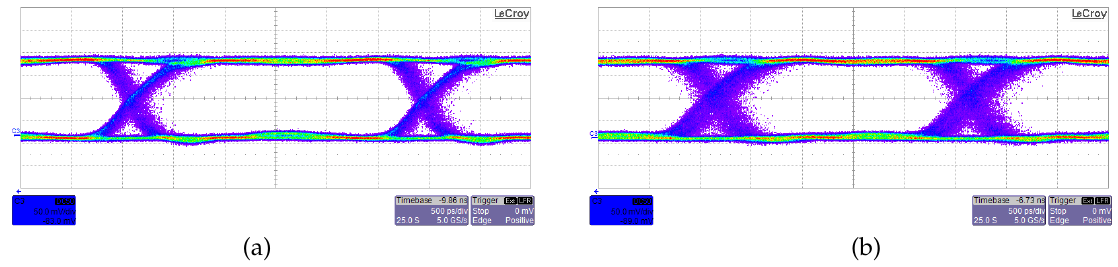
Figure 5. Eye diagram of the output signal of the OEIC at ( a ) 350Mbit/s, average optical power −27.4dBm; and ( b ) 400Mbit/s, average optical power −26.0dBm. 2 31 − 1 PRBS, BER = 10 −9 , λ = 635nm, extinction ratio =